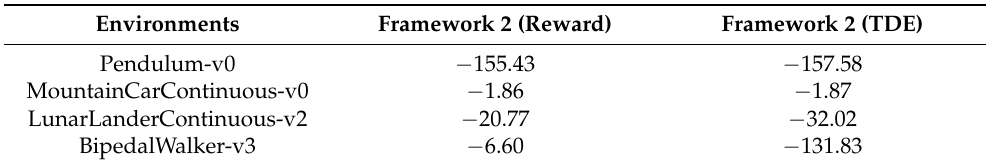
Figure 7. Performance of algorithms on the Pendulum-v0 environment. Table 7. The performance of Framework 2 using the F2F1 retention strategy, a sampling ratio of 9:1, and a replay buffer of 1e6 across other continuous